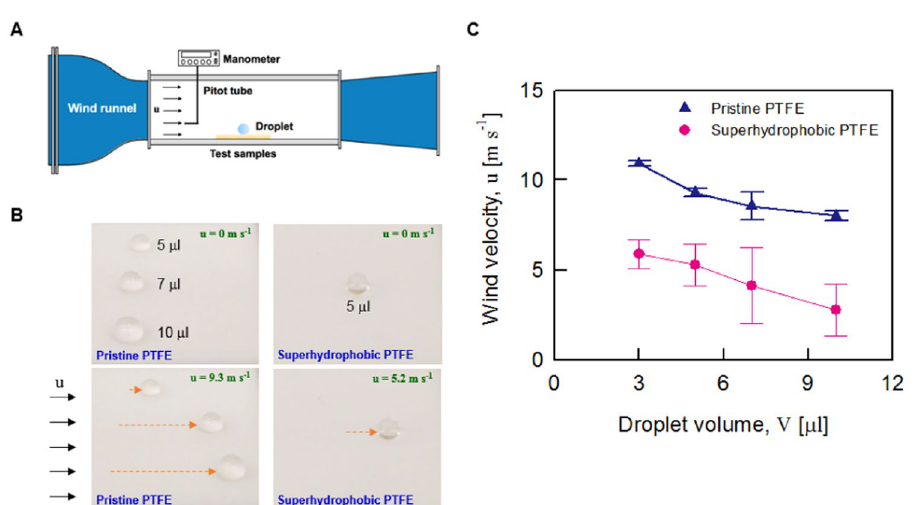
Figure 2. Self-cleaning effect of the fabricated superhydrophobic PTFE sheets. ( A ) The removal of water droplets of 5 μ L, 7 μ L, and 10 μ L in volume was examined with varying wind speed. The test samples were attached on the bottom of the wind tunnel test section. Wind velocity was measured by a Pitot tube. ( B ) Water droplets on the pristine PTFE start to move when the wind velocity is 9.3 m s − 1 . A water droplet of 5 μ L in volume starts to move at 5.2 m s − 1 . ( C ) Variations of the wind velocity to detach various volumes of water droplets attached on the pristine PTFE and superhydrophobic PTFE